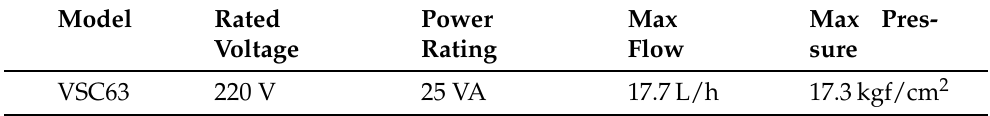
Table 1. Solenoid pump